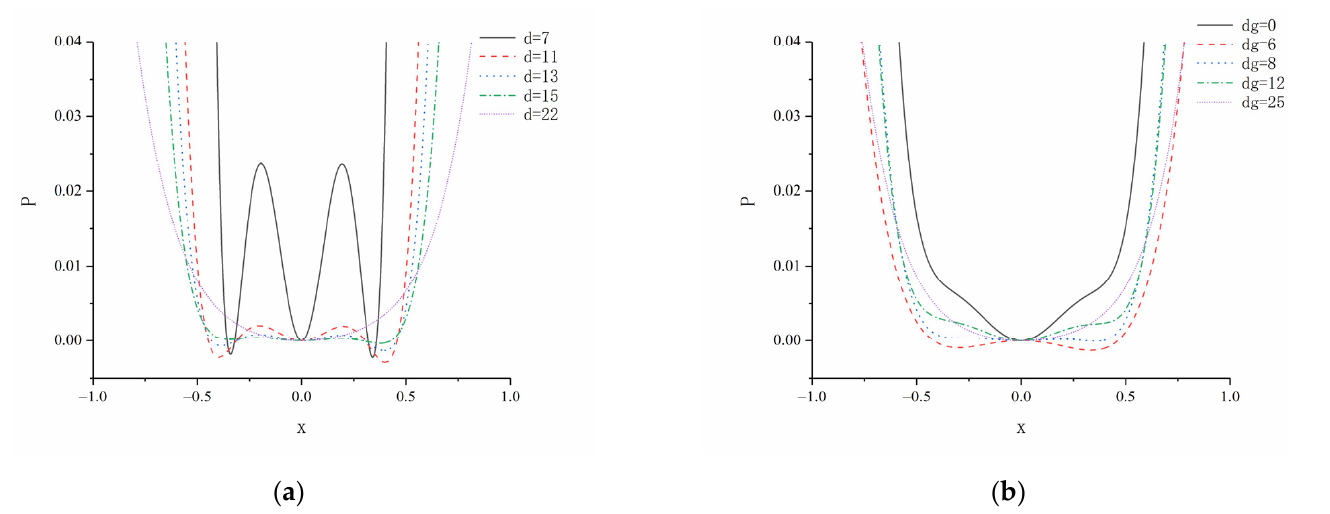
Figure 5. System potential energy of different magnetic distance: ( a ) change the horizontal magnetic distance d ; ( b ) change the vertical magnetic distance d g